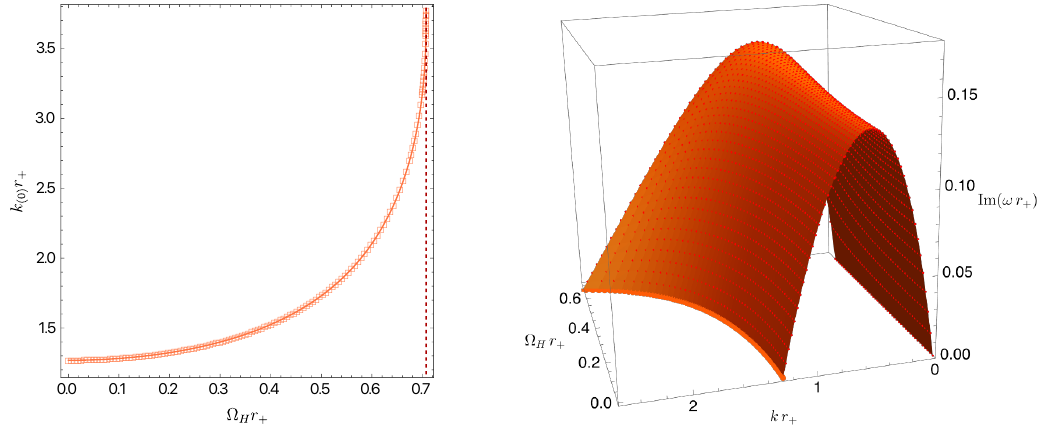
Figure 1 . Onset mode wavenumber (left) and growth rate (right) of the axisymmetric ( m = 0 ) Gregory-Laflamme instability for Myers-Perry black strings. In the left panel, unstable modes have e k < e k (i.e. e L > 2 π/ e k are unstable). The vertical dashed line marks extremality with (0) (0) √ 2 ' 0 . 707107 . Critical wavenumbers are e k ' 1 . 268916 at e Ω H = 0 [2] and e k e Ω H = 1 / (0) at Ω H ' 0 . 999996 Ω ext ' 0 . 707104 (extrapolates to e k ' 3 . 783201 at Ω H = Ω ext (0) H